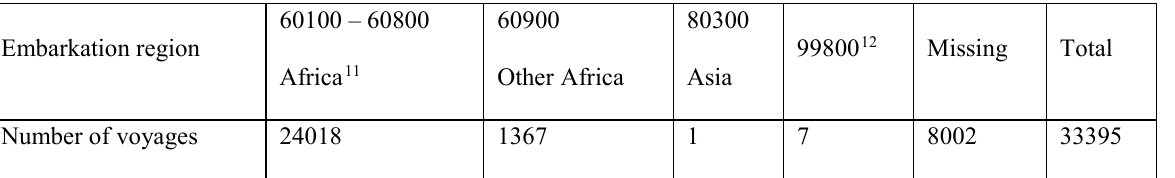
Table 2. TASTDB 2010 records by embarkation region, 1650s to 1860s.